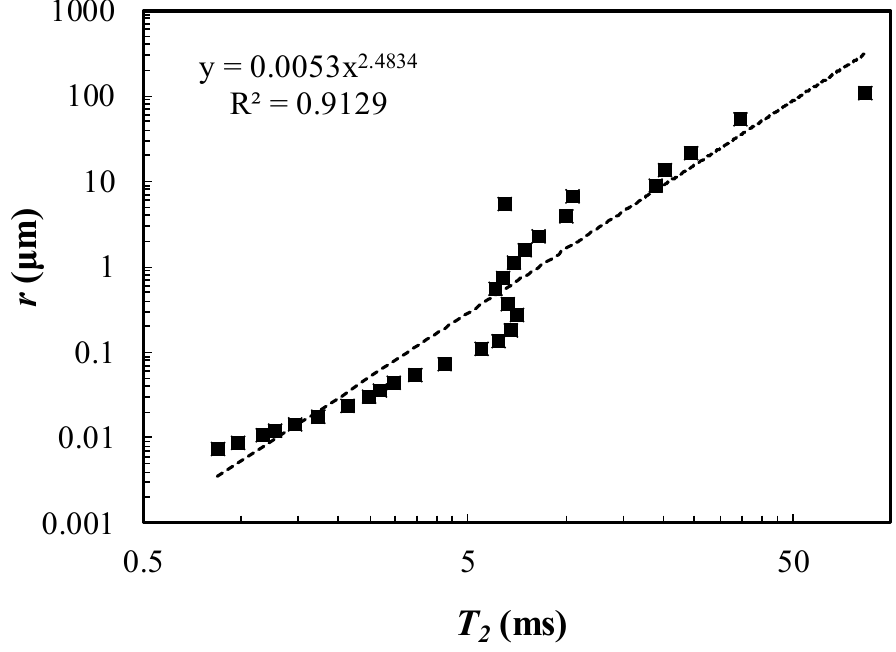
Figure 10. The pore throat sizes and corresponding NMR T 2 are fitted with a power function.